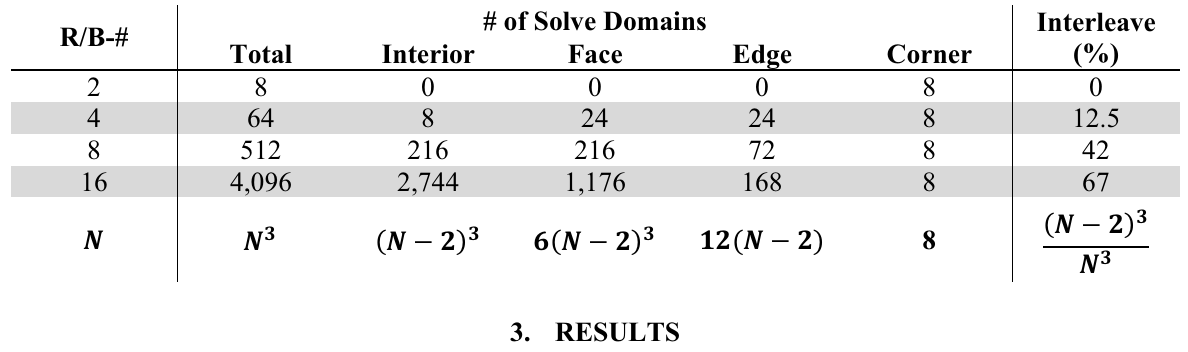
Table 1: Achievable Total Iteration Interleave for Various R/B-# Before First Message Required # of Solve Domains Interleave R/B-# (%)Total